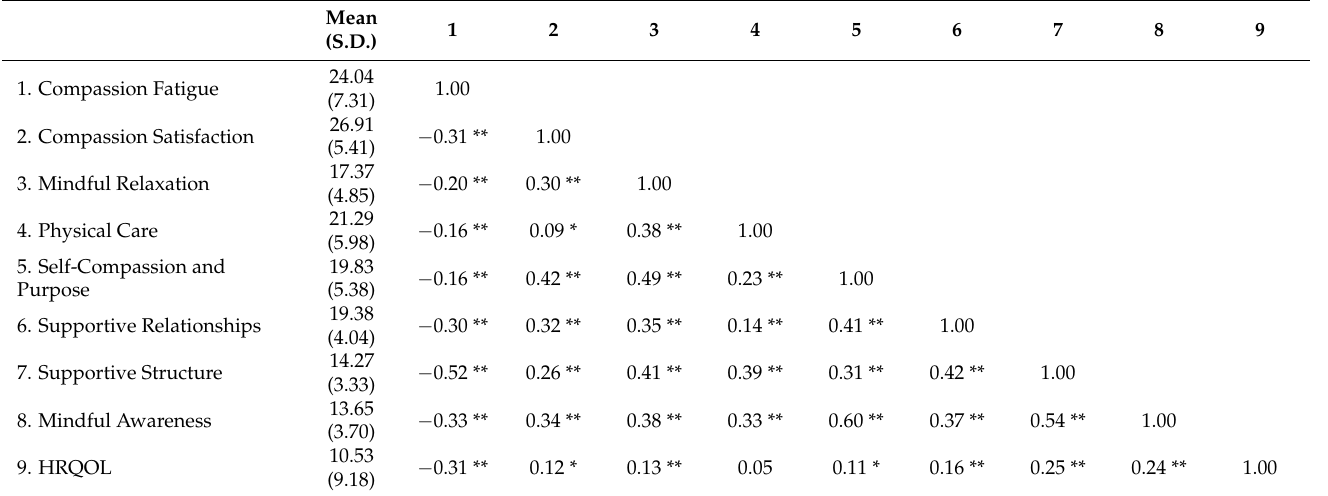
Table 3. Bivariate Correlations of Measured